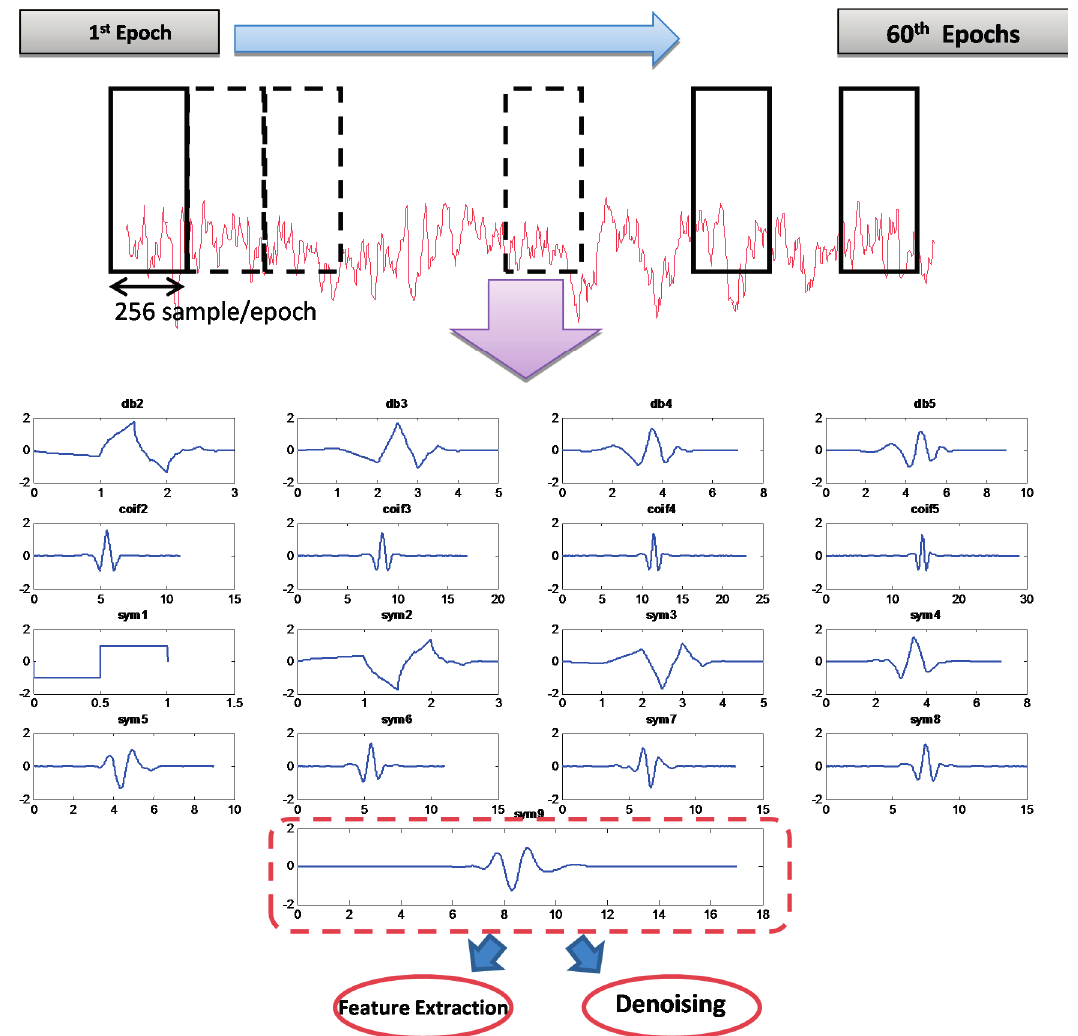
Figure 5. Noisy EEG epochs and mother wavelet of Daubechies (db order from 2 to 5), Coiflets (coif order from 2 to 5) and symlet (sym order from 1 to 9) representation. The (cid:1850)(cid:1829)(cid:1867)(cid:1870)(cid:1870) results of the 19 channels were grouped into five recording regions corresponding to the scalp region. These regions include the frontal region of the seven frontal channels (Fp1, Fp2, F3, F4, F7, F8, and Fz), the temporal region of the four temporal channels (T3, T4, T5, and T6), the parietal region of the three parietal channels (P3, P4, and Pz), the occipital region of the two occipital channels (O1 and O2), and the central region of the three central channels (C3, C4, and